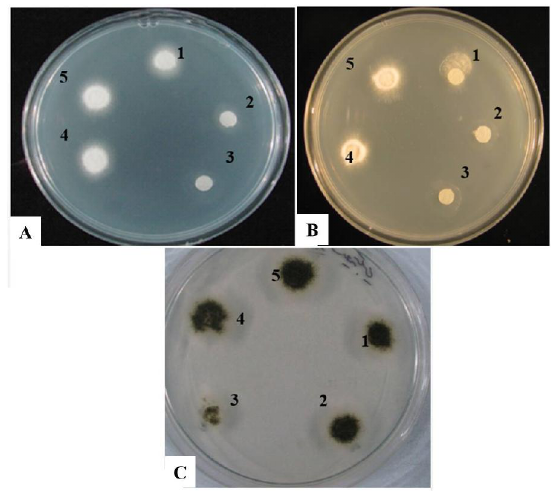
Fig. 5. In vitro antifungal spore germination showing inhibition of the spore germination of different plant pathogenic fungi: (A) F. oxysporum ; (B) V. dahliae and (C) A. solani (1, 2, and 3= Different concentrations of 2, 5 and 10 µg of purified protein; 4= Protein extract of empty vector; 5= Elution buffer).